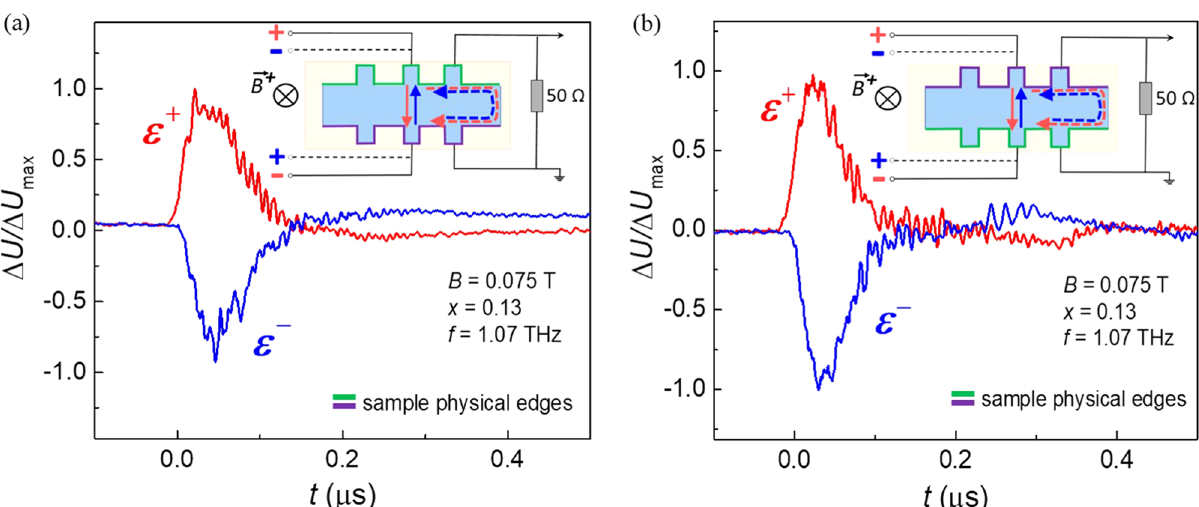
Figure 6. Nonlocal photoresponse before and after the sample rotation. Photoconductivity kinetics measured in the initial (a) and upside-down (b) sample positions. Physical sample edges are marked by respective colours in the insets. The film composition x = 0.13 corresponds to the topological phase, the magnetic field B + = 0.075 T, the terahertz laser frequency is 1.07